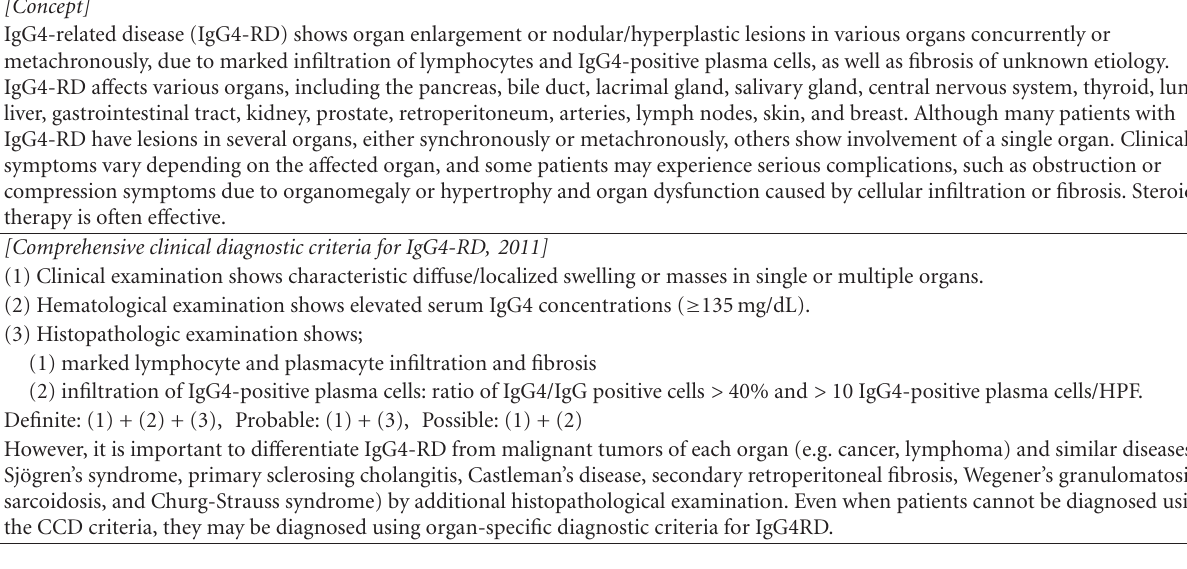
Table 5: Comprehensive diagnostic criteria for IgG4-related disease (IgG4-RD), 2011